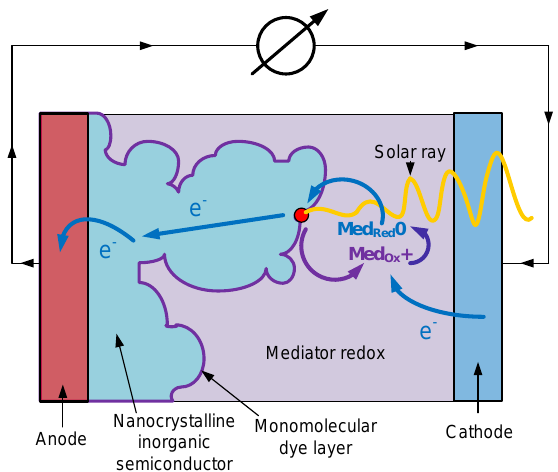
Figure 5. Operation of a dye-sensitized solar cell (DSSC).